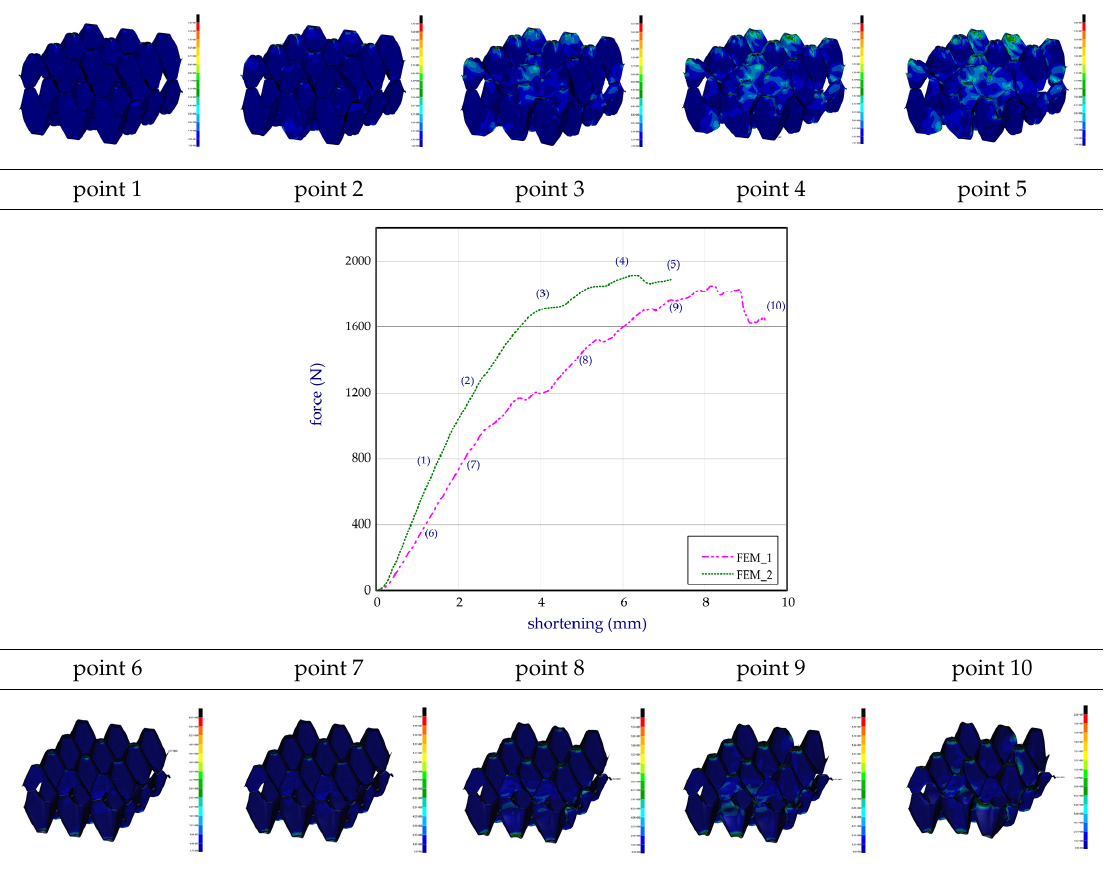
Table 2. Von Mises stress maps for FEM_1 (on the bottom) and FEM_2 (on the top).